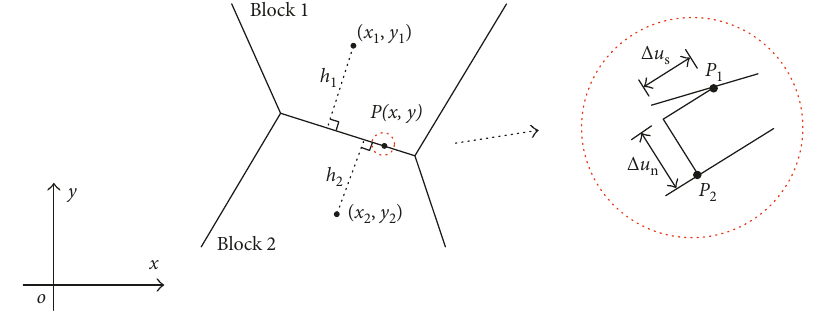
Figure 3: Local deformation of an interface.